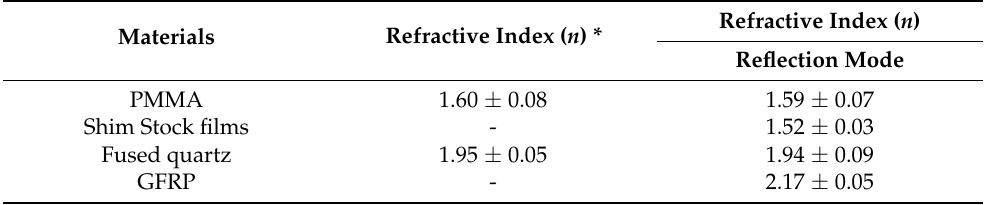
Table 1. Averaged THz refractive indices of the individually studied